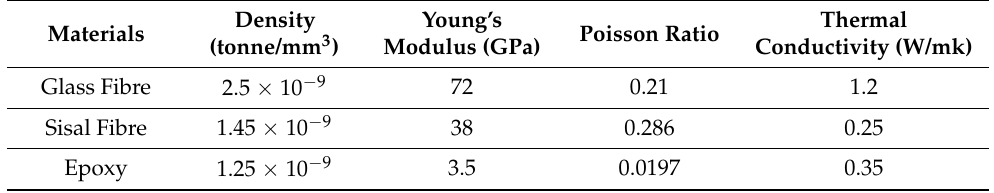
Figure 12. Different stages of model development in ANSYS. Table 5. Property materials utilized in ANSYS [46]. Materials Density (tonne/mm 3 ) Young’s Modulus (GPa)